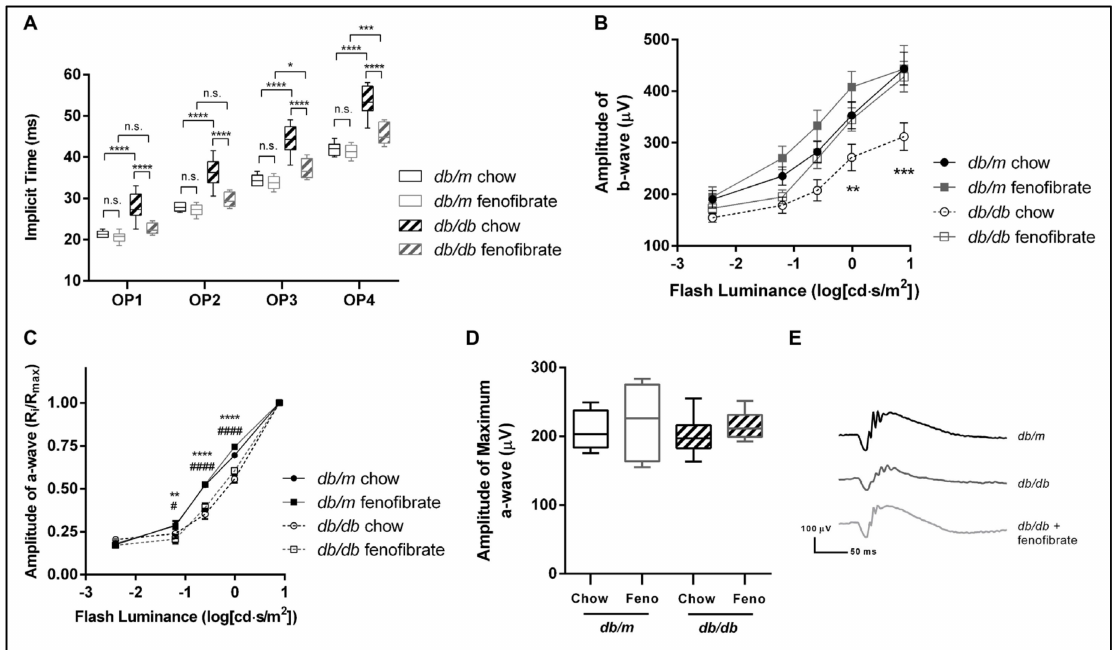
Figure 2. Oral fenofibrate attenuates diabetes-related changes in electroretinography. Diabetic db/db mice and their heterozygous db/+ siblings were maintained on a fenofibrate-supplemented diet or standard chow and underwent elec- troretinography (ERG) at six months of age. ( A ) The implicit time for the first four oscillatory potentials (OP1–OP4) is shown. A statistically significant delay of all four oscillatory potentials occurs in db/db mice maintained on regular chow relative to littermate controls. This delay was attenuated in db/db mice maintained on fenofibrate-supplemented diets. ( B ) B-wave amplitude was measured at a range of flash luminance. Significantly reduced b-wave amplitudes at higher luminance values were observed in db/db mice fed regular chow, but not in db/db mice given fenofibrate. ( C ) A-wave amplitudes across a range of flash luminance are shown. A-wave reduction was noted at some levels of luminance for db/db mice regardless of diet. ( D ) No differences in the maximum a-wave amplitude were observed between the four groups. n = 10 per group. * = p < 0.05, ** = p < 0.01, *** = p < 0.001, **** = p < 0.0001, two-way ordinary ANOVA, compared to healthy control within same treatment group. # = p < 0.05, #### = p < 0.0001, two-way ordinary ANOVA, compared to genotype-matched control in the opposite treatment group. ( E ) Illustrative scotopic electroretinograms from a − 0.01 log(cd · s/m 2 )